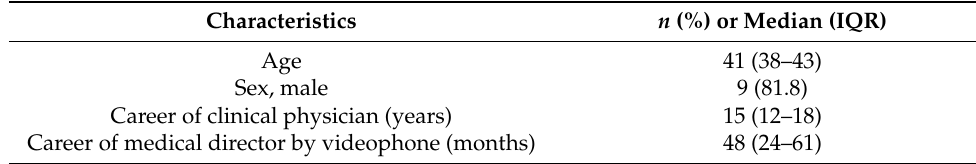
Table 1. Demographic characteristics of experts ( n = 10).